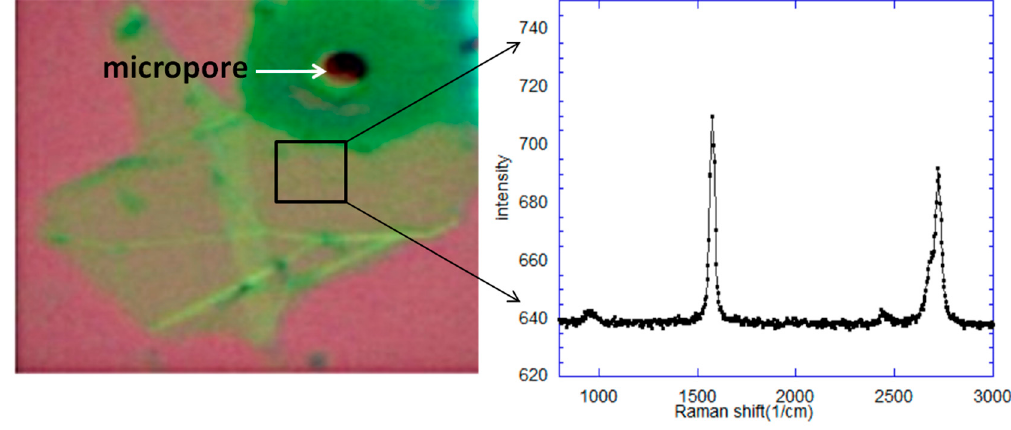
Figure 4. Optical image and Raman spectra of graphene transferred onto the Si micropore.